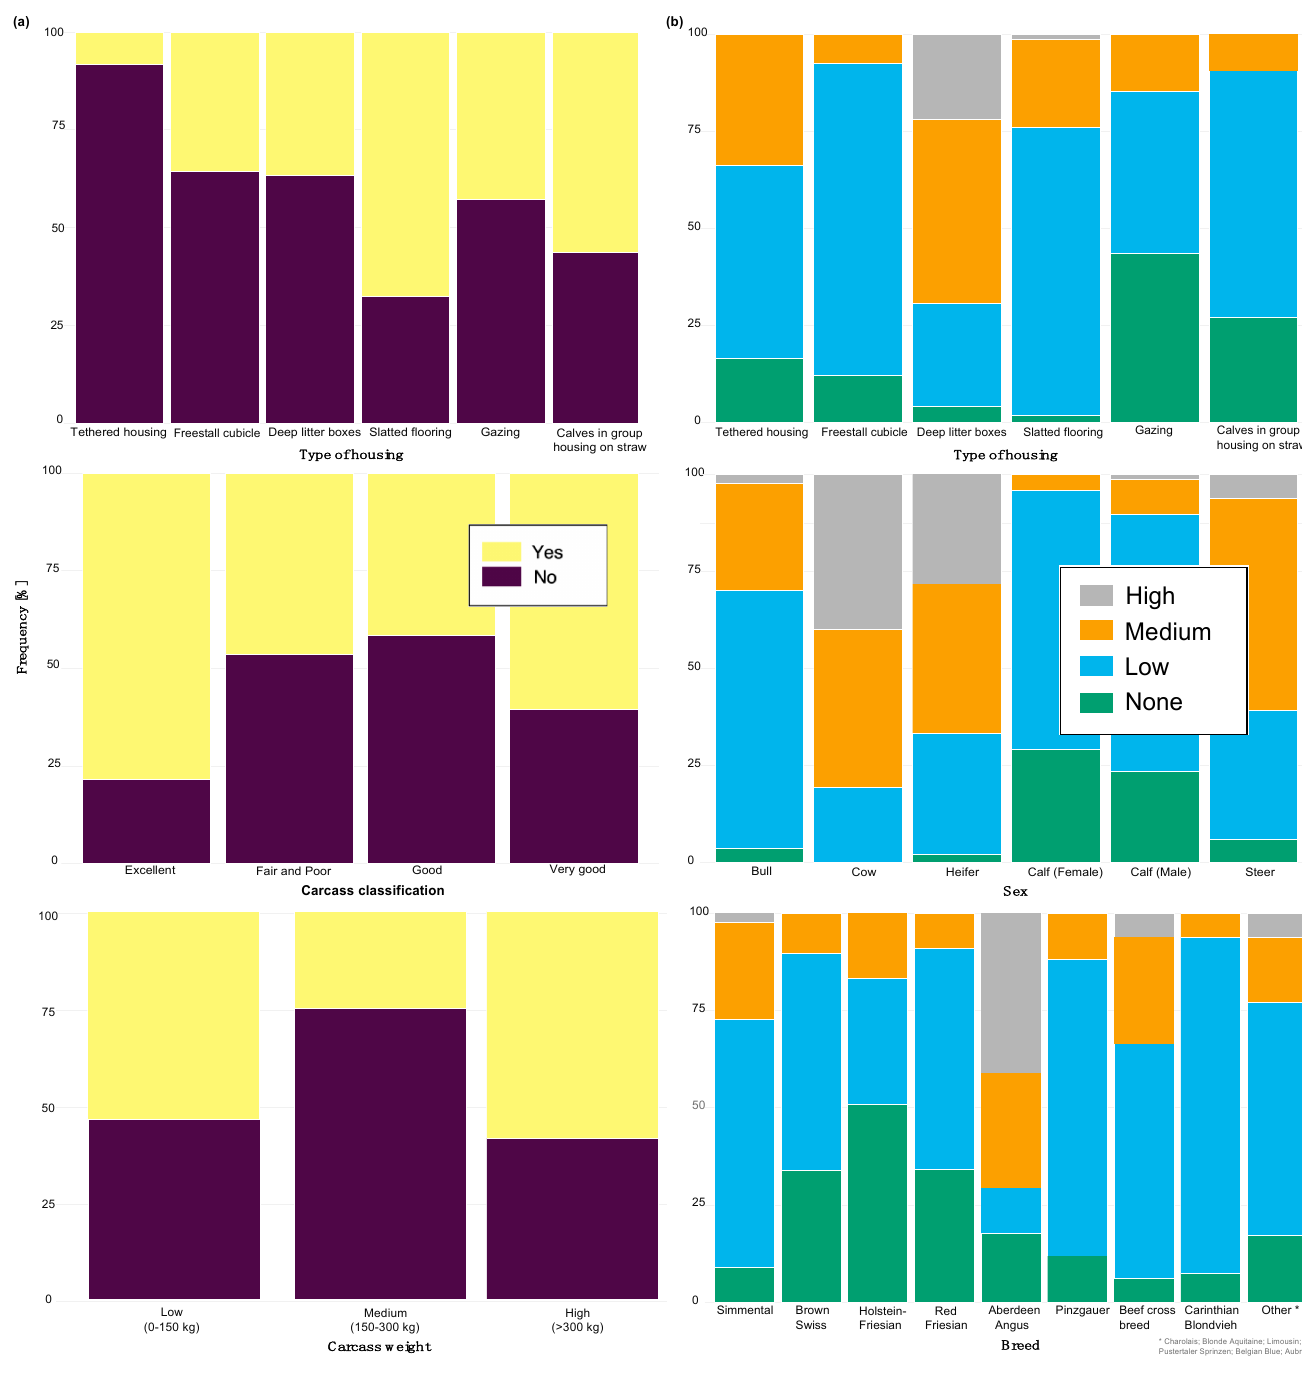
Figure 2. Frequency of recorded ( a ) abomasal mucosa alterations (Yes = presence of abomasal mucosa lesions; No = no presence of 223 abomasal mucosa lesions) stratified by fixed factors considered in the final model, i.e., type of housing, carcass classification, and 224 carcass weight, and ( b ) cleanliness level stratified by fixed factors considered in the final model, i.e., type of housing, sex and breed. 225